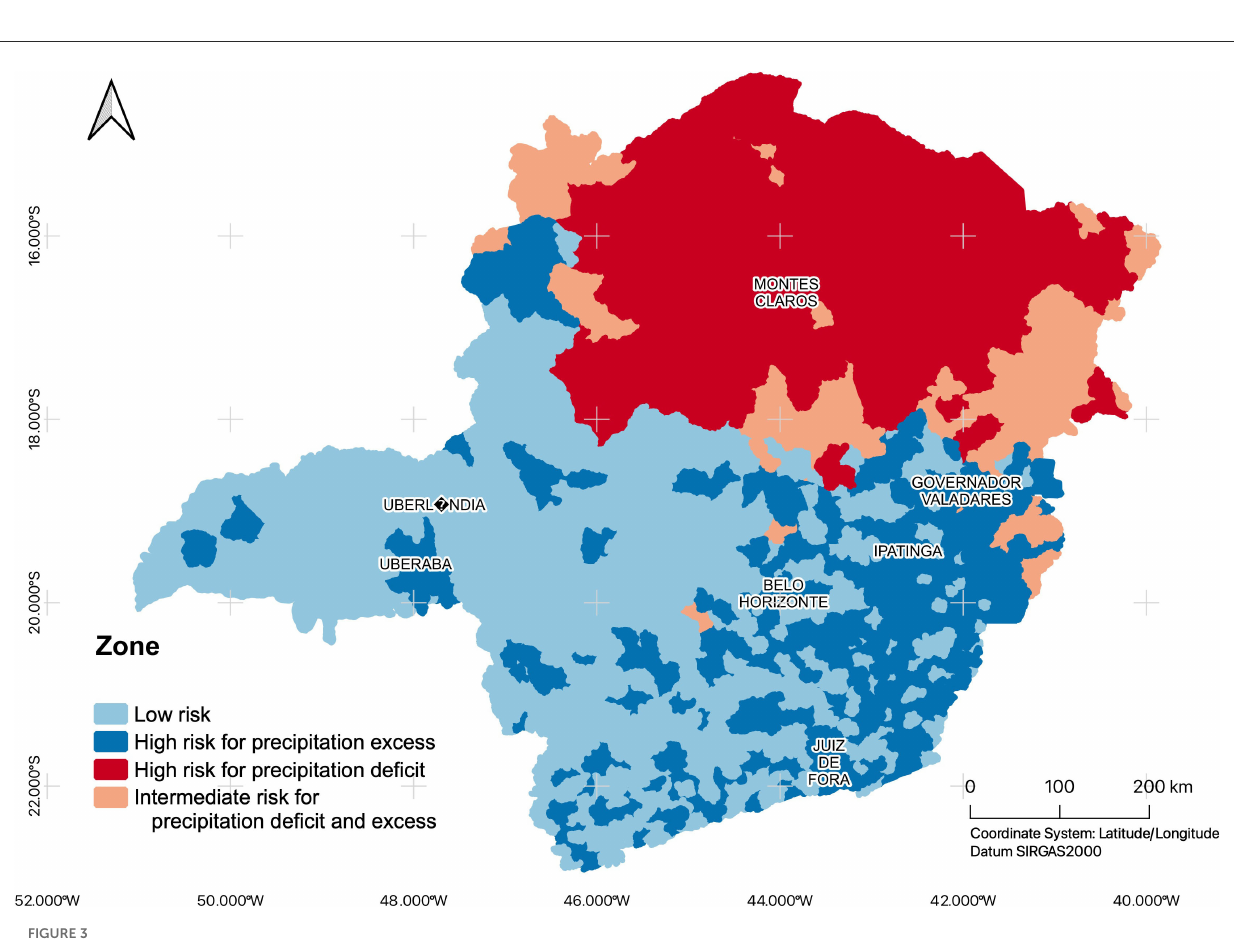
such as floods, droughts, and landslides (Quintão et al., 2017; Avila-Diaz et al.,